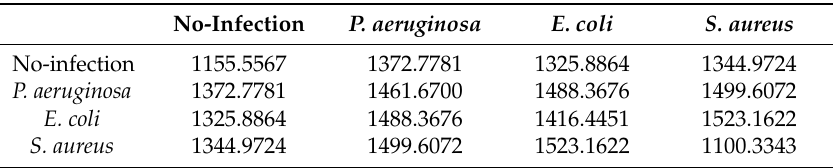
Table 3. Average Euclidean distance of points in matrix